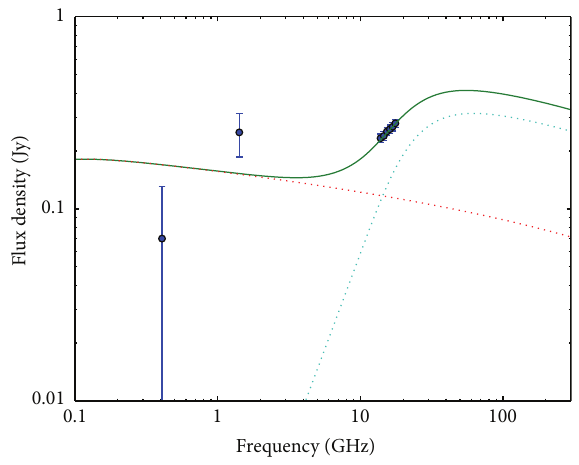
Figure 5: SED for AME-G107.1+5.2. The fluxes at 0.408 and 1.42GHz are from the CGPSE catalogue normalised by the flux loss expected in AMI channel 3; the higher frequency fluxes are the flux-loss-corrected AMI fluxes. Two free-free SED components are shown using a source size for the low-frequency component fixed to that measured from the AMI SA